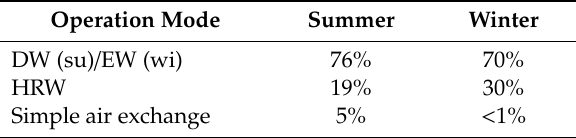
Table 3. Relative shares of operation modes.